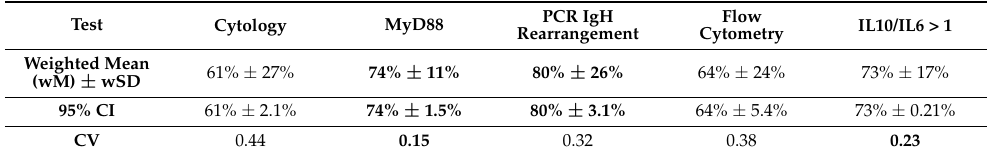
Table 3. Weighted aggregate data of the different tests. The two highest mean and confidence interval as well as the lowest coefficient of variation values are highlighted with